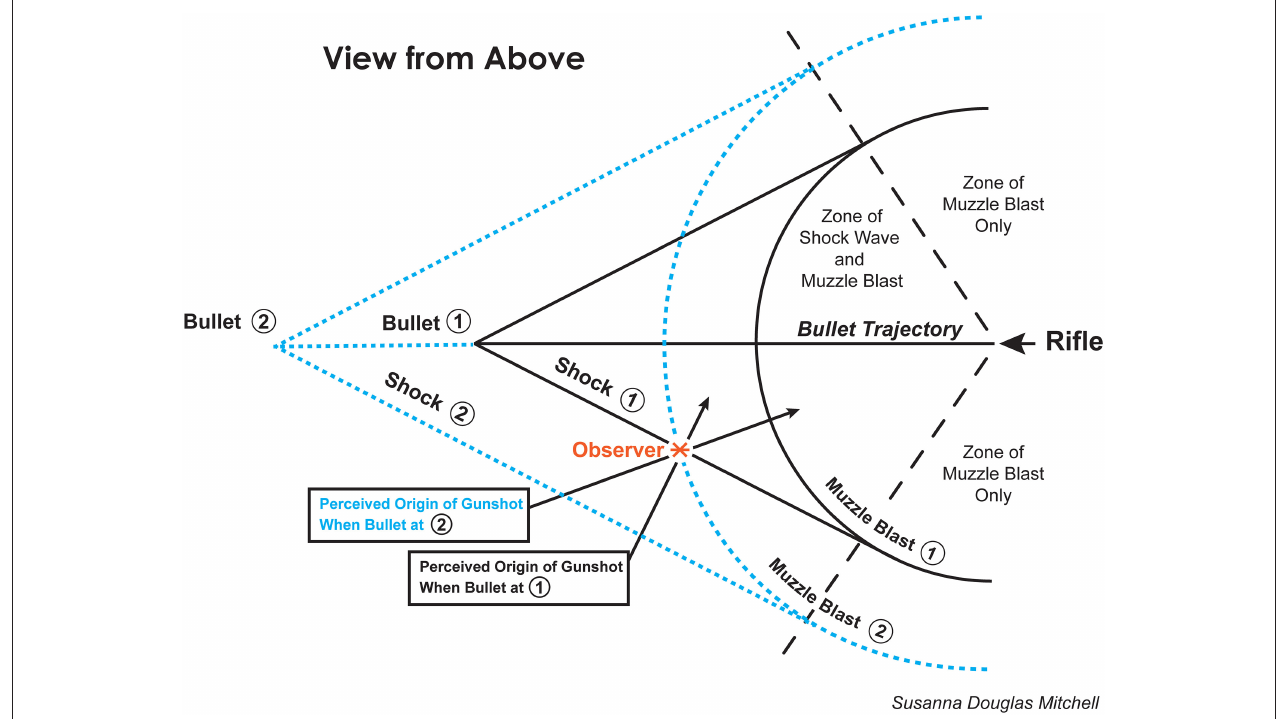
FIGURE 2 | A diagram of the muzzle blast and the shock wave associated with a gunshot from a rifle firing supersonic bullets. The rifle is located at the right of the figure and the bullet proceeds toward the left. The curved lines in the figure illustrate the muzzle blast propagating spherically away from the rifle, and the cone-shapes illustrate the path traversed by the shock wave propagating away from the path of the bullet. Because the bullet travels faster than the speed of sound, the sound produced by the shock wave arrives prior to the sound produced by the muzzle blast at most locations in front of the gunman. When the bullet reaches position 1, an ideal observer located at the red asterisk would hear the sound generated by the shock wave and would localize the source as the path of the bullet. This judgment is correct based on the stimulus, but incorrect about the origin of the bullet. When the bullet reaches position 2, an ideal observer located at the red asterisk now hears the muzzle blast and localizes that source as the location of the gunman. Of course, humans are not ideal at separating the two sources of sound, so the potential for confusion is high (The duration of the N wave increases moving from left to right along the edges of a cone; see text). Figure adapted from Green (1979) by Susanna Douglas